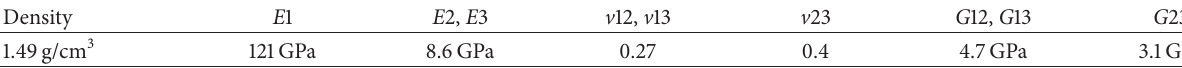
Table 1: Mechanical properties of a bisphenol A epoxy matrix prepreg.